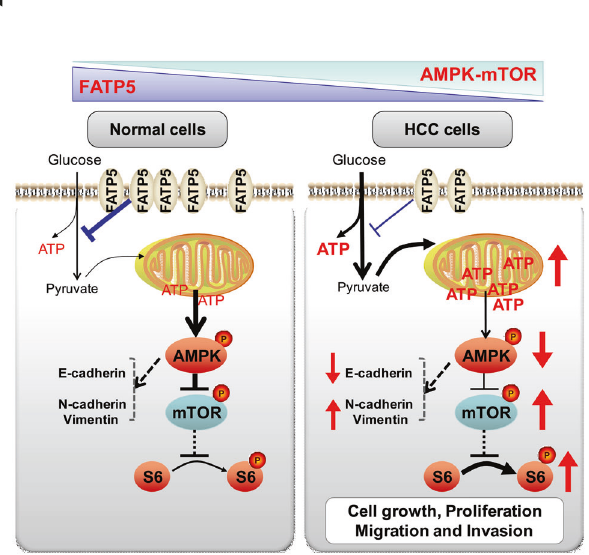
Fig. 6 Proposed working model of FATP5-mediated effects on HCC cells. The loss of FATP5 leads to an increase in metabolic fl ux of glycolysis and ATP generation, which inhibits AMPK and activates its downstream mTOR-S6K-S6 signaling pathway, thereby promoting HCC cell growth, migration, invasion, and HCC tumorigenesis. Abbreviations: p-,